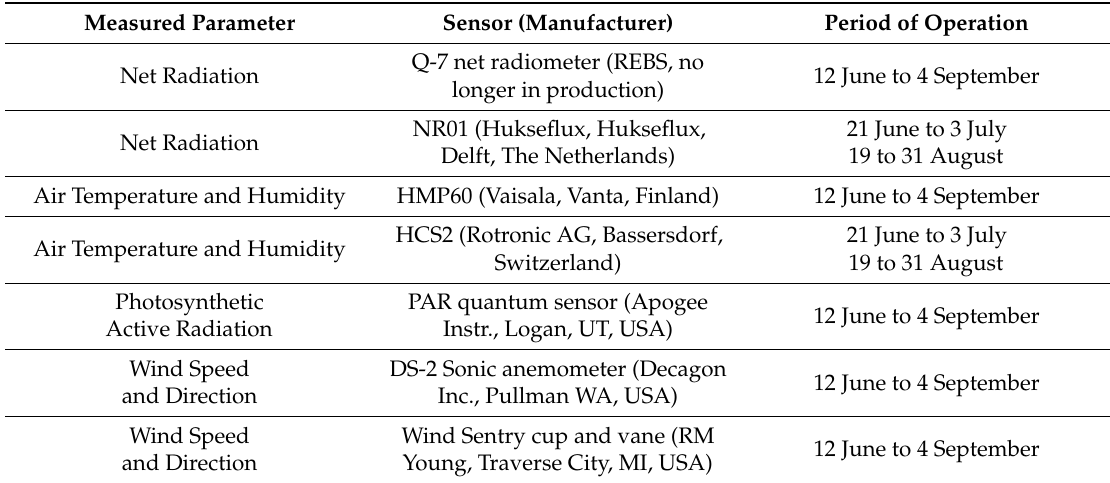
Table 2. Sensors from 2017 Field Experiment used in this